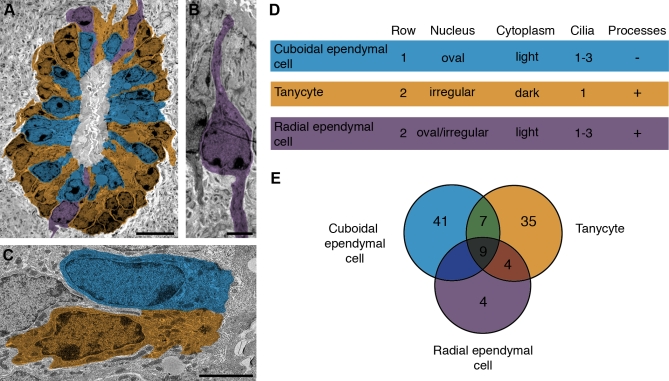
Characterization of Spinal Cord Ependymal Cells(A–C) Immunoelectron microscopy of the central canal in a FoxJ1-CreER mouse. Pseudocoloring in (A) illustrates the localization of CreER-immunoreactive radial ependymal cells (B), cuboidal ependymal cells, and tanycytes (C).(D) Table with color code for (A–C), describing the characteristics of the three cell types that line the central canal.(E) Venn diagram illustrating the percentage of cuboidal ependymal cells, tanycytes, radial ependymal cells, and intermediate morphologies (see Figures S4 and S5, and Table S1 for details on the ultrastructural analysis). Scale bars indicate 10 μm in (A) and 3 μm in (B) and (C).